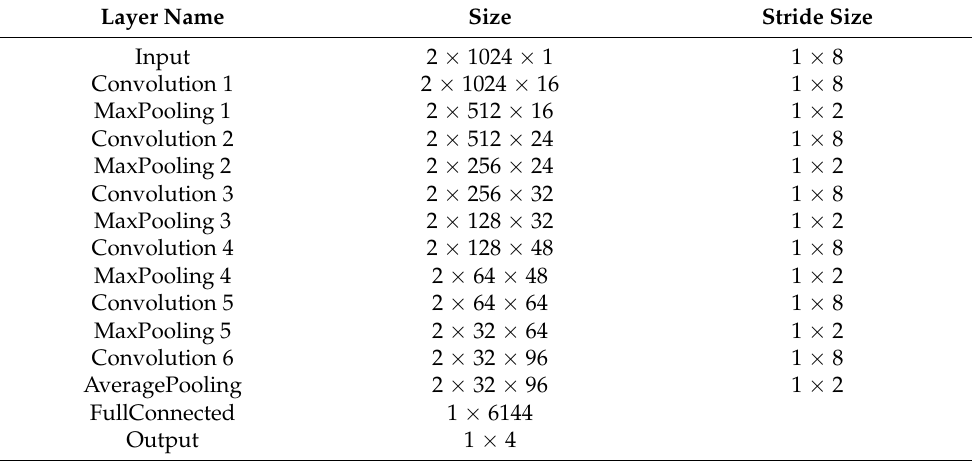
Table 1. Network parameters of major layers.